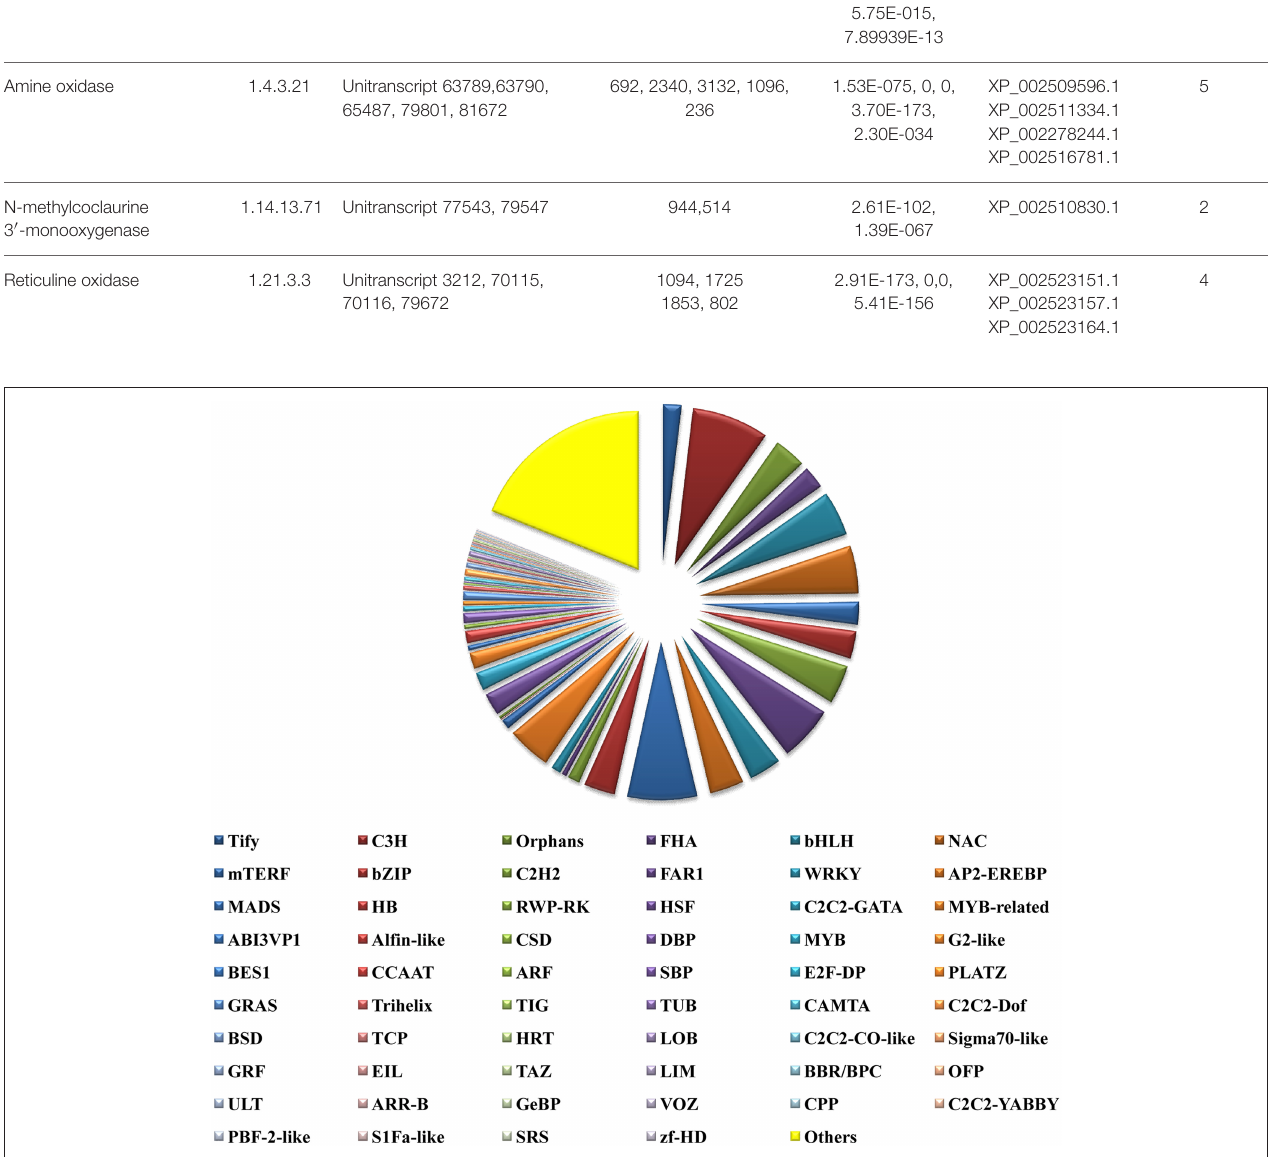
FIGURE 10 | Transcription factors identified from leaf transcriptome of P. amarus de novo assembled unitranscripts.